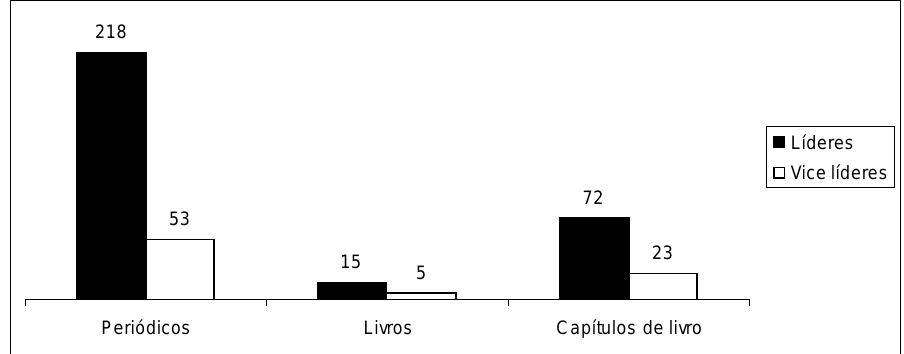
Figura 9. Publicação dos líderes e vice-líderes dos